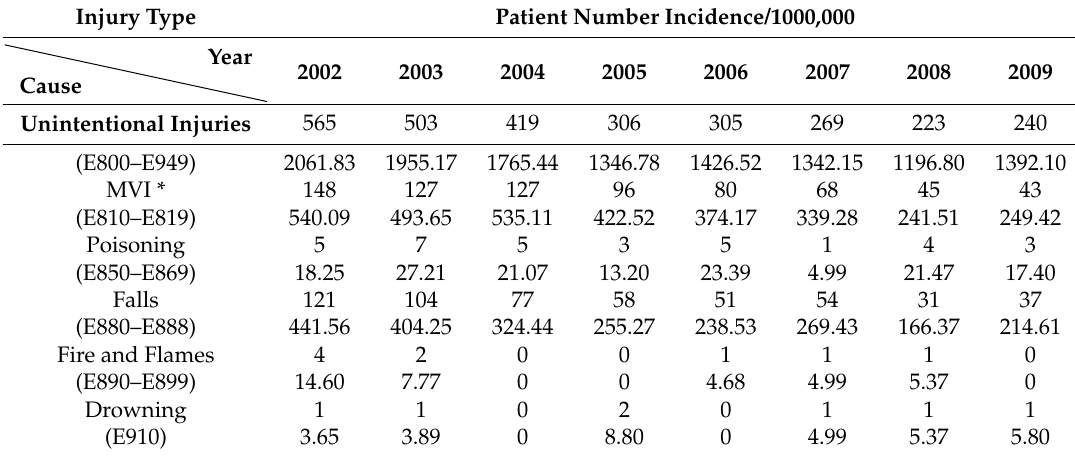
Table 1. Annual incidence of accidental injuries of pediatric emergency